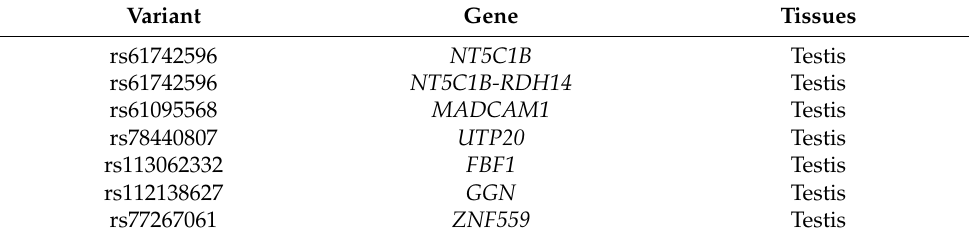
Table 6. Prioritized variants on eQTL regions according to GTEx database.